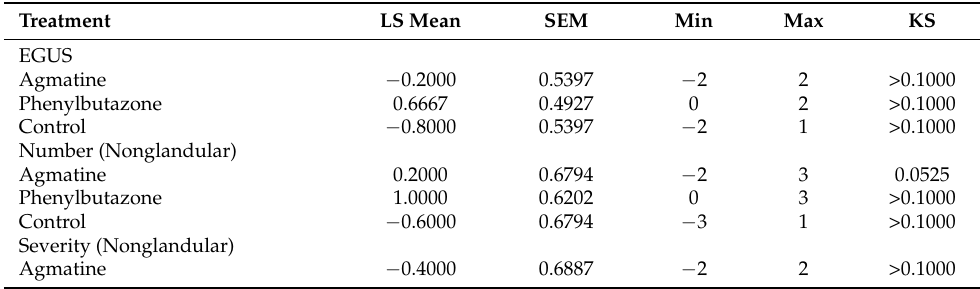
Figure 5. Changes in equine gastric ulcer syndrome (EGUS) scores ( A ) and number and severity of gastric non-glandular and glandular mucosa ulcer scores ( B ) between 1 day before and after 31 days of oral agmatine (blue), phenylbutazone (orange) or control (white) administration (LS mean ± SEM). Asterisks indicate significant differences among treatments ( p < 0.05). A hash symbol indicates a significant change from the baseline. Table 8. Changes in gastric ulceration score. Min: minimum; Max: maximum; KS: p -value of Kolmogorov–Smirnov